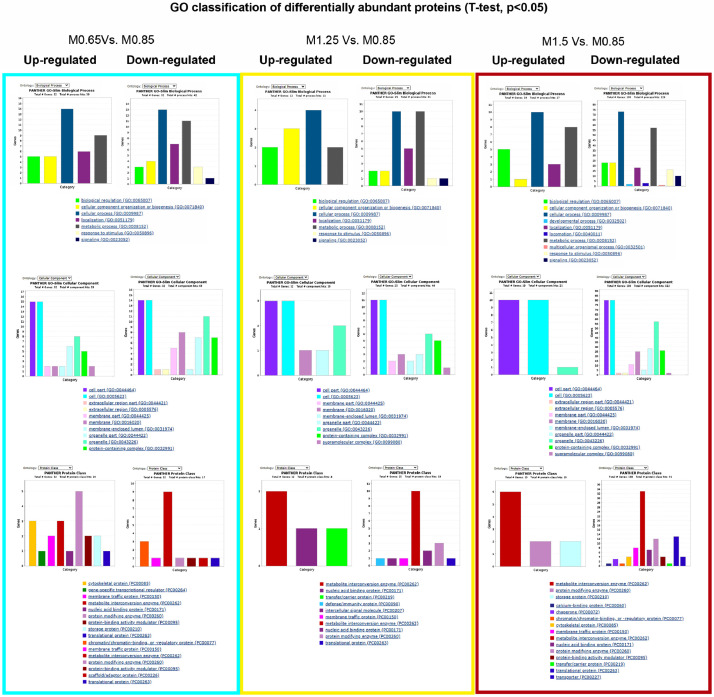
Gene Ontology (GO) classification of proteins with significant differences in abundance (Student's t-test, p < 0.05) between fish fed with Met-treatment versus reference diet (M0.85), according to Biological Process, Cellular Component and Protein class categories.